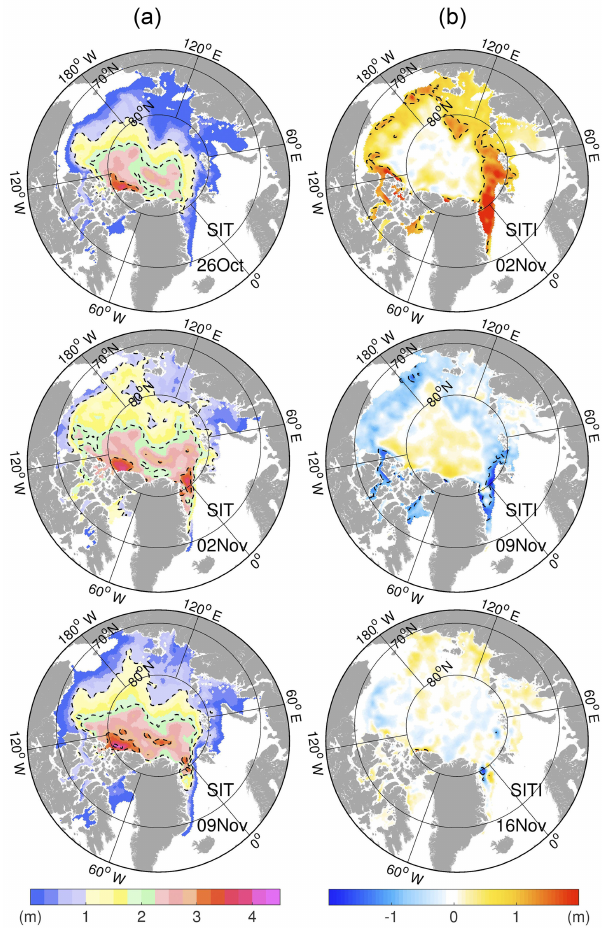
2 November; 3–9 November) from CS2SMOS in the beginning of fall 2014. The dashed white lines denote the 1, 2, 3 and 4m isolines. (b) The associated time increments of SIT relative to the last weekly SIT. The dashed isolines denote ±